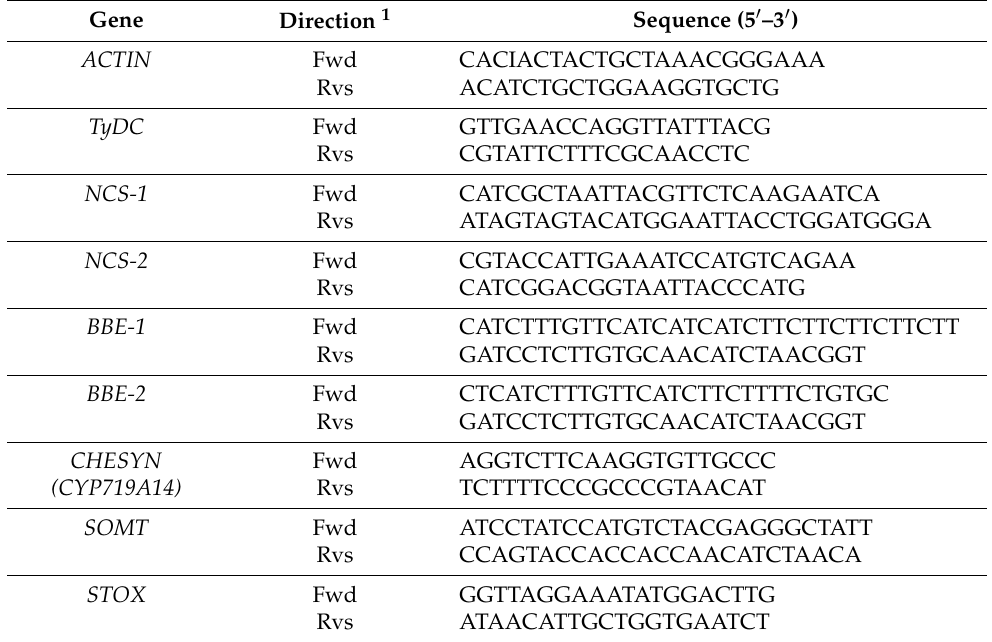
Table A1. Sequence of the primers used for